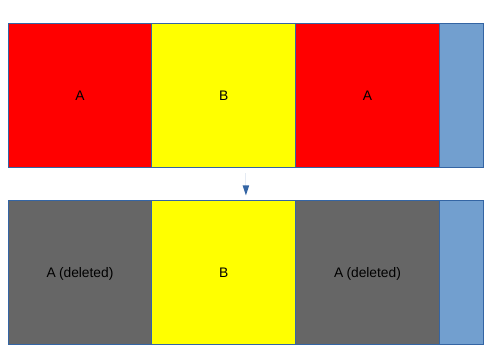
Figure 6. Test Case 2. Fragmented file A is deleted.